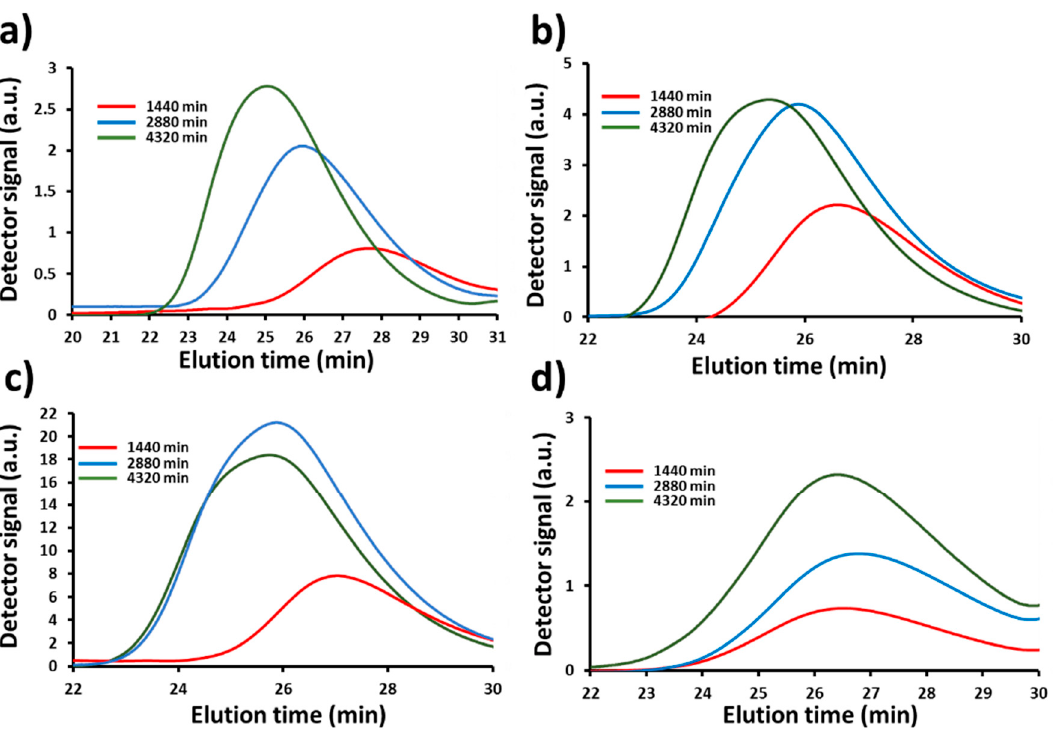
Figure 8. GPC traces (elution time) of DBI-S copolymerizations at 70 °C at ( a ) f DBI,0 = 0.60, ( b ) f DBI,0 = 0.70, ( c ) f DBI,0 = 0.80 and ( d ) f DBI,0 = 0.90. Table 4. Summary of dibutyl itaconate/styrene copolymerizations in 50 wt% dioxane solution at 70 °C at different initial compositions.